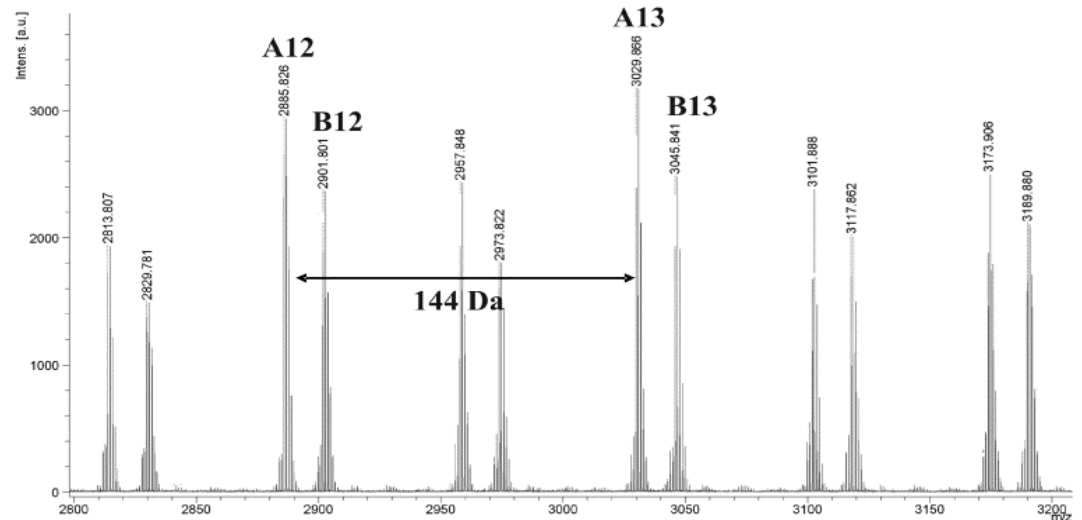
Figure 7. MALDI-TOF MS spectrum of the β -CD/PLA100 polymer obtained at 100 °C.